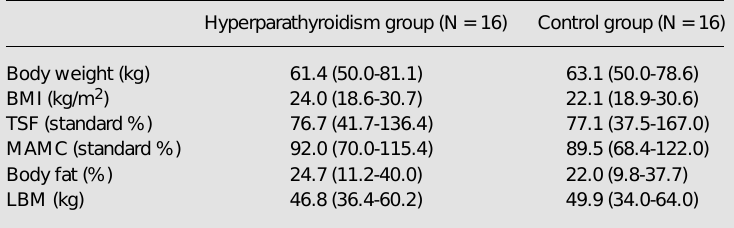
Table 2 - Anthropometric indices. Data are reported as median and range (in parentheses). BMI = Body mass index, TSF = tricipital skinfold thickness, MAMC = midarm muscle circumference, LBM = lean body mass.